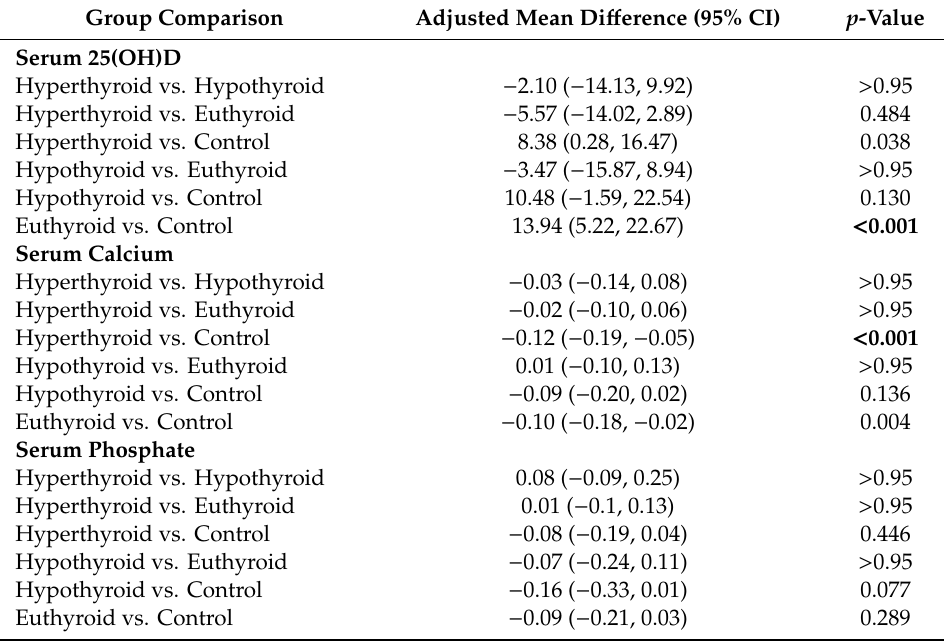
Table 7. Post hoc pairwise comparison of ANCOVA analysis for mean serum 25(OH)D, serum calcium and serum phosphate adjusted for age and gender in between